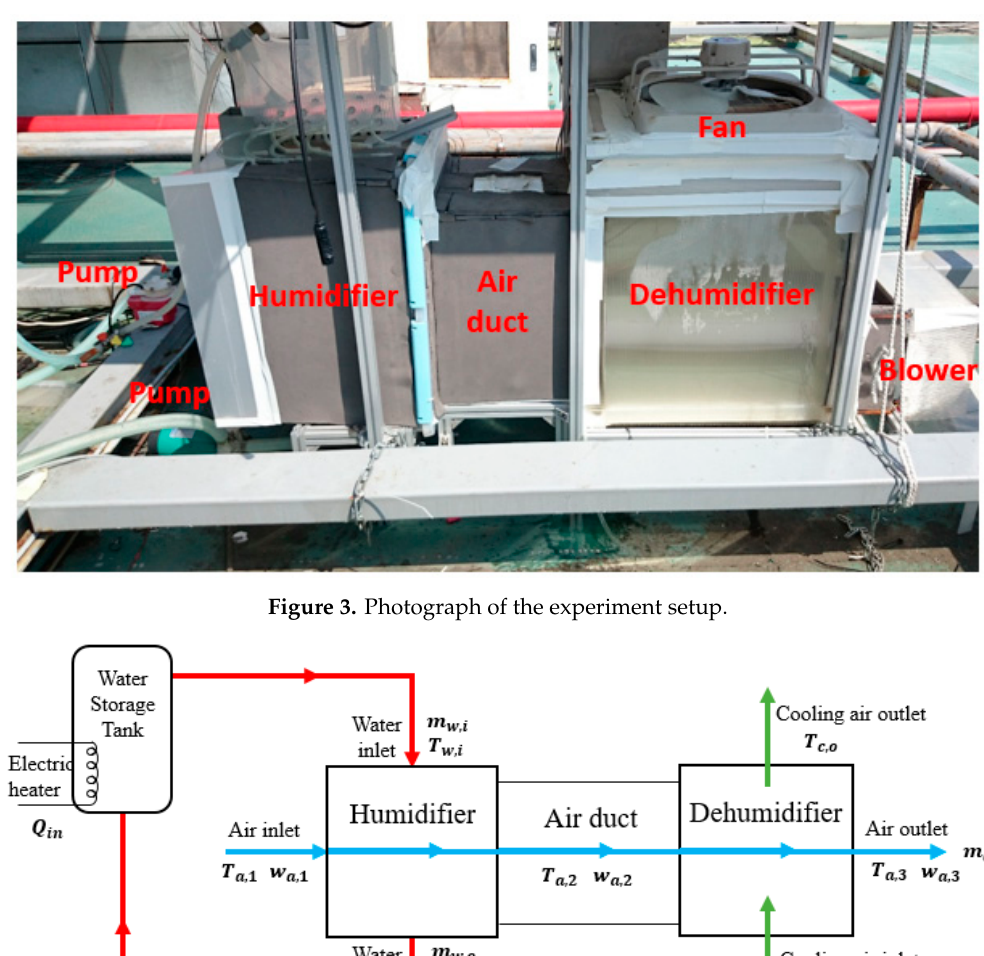
Figure 4. Diagram of the air-cooling HDH system for thermodynamic analysis.